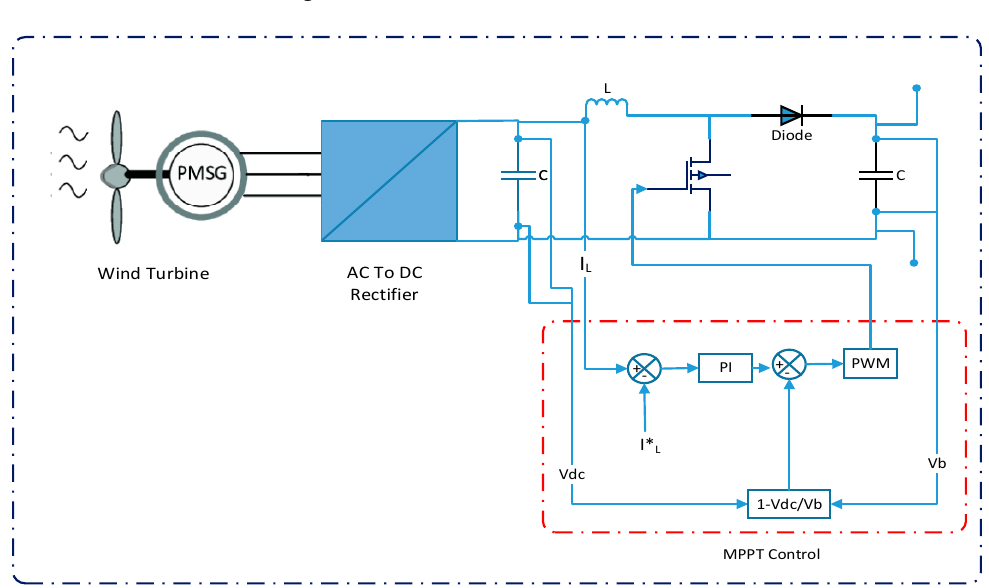
Figure 14. MPPT control of boost converter.